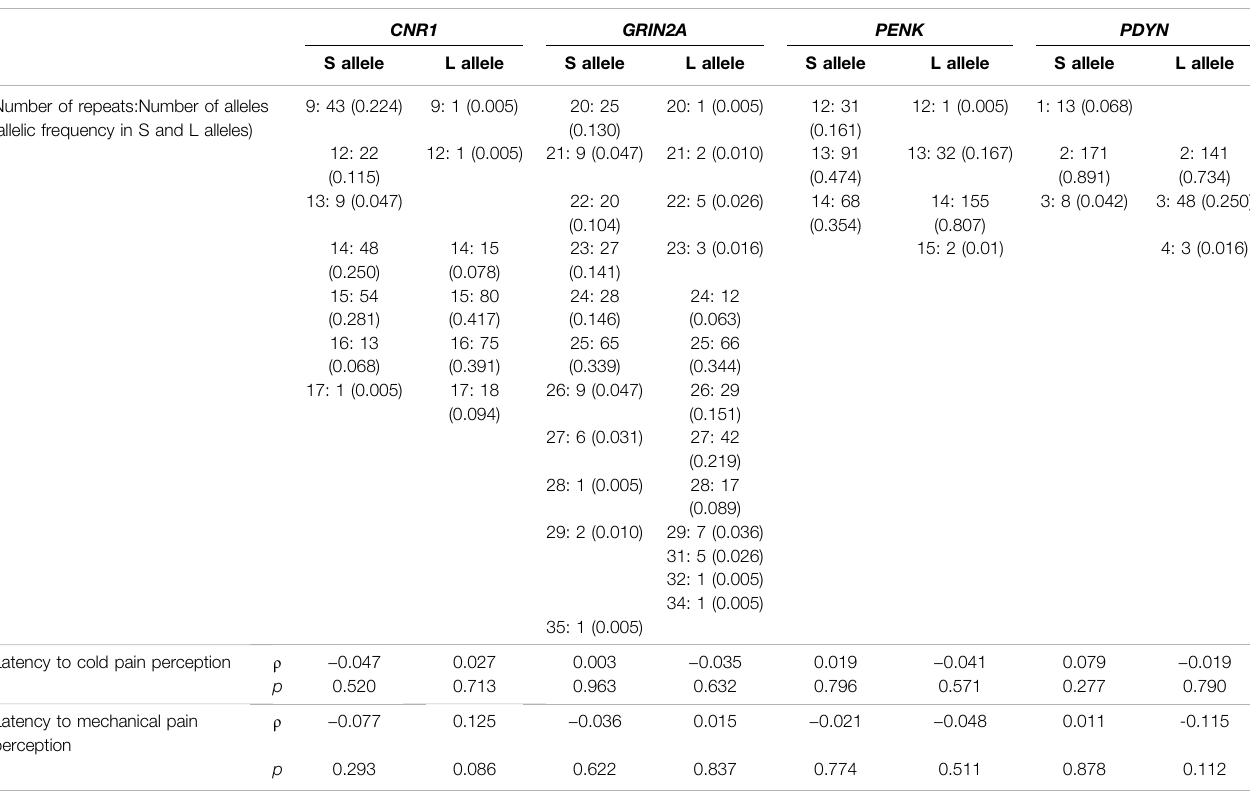
TABLE 3 | Associations between S and L alleles of STRs and peripheral pain